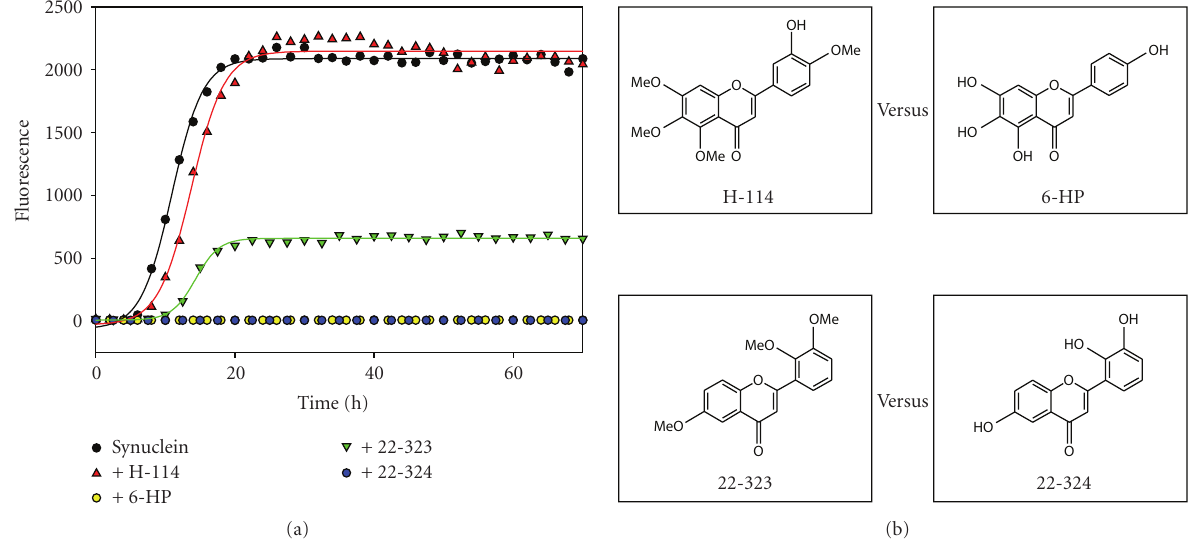
Figure 14: Loss of inhibitory e ff ects of flavonoids on α -synuclein fibrillation with hydroxyl groups replaced by methoxyl groups. Comparison is made between 6-HP versus H-114, and 22-324 versus